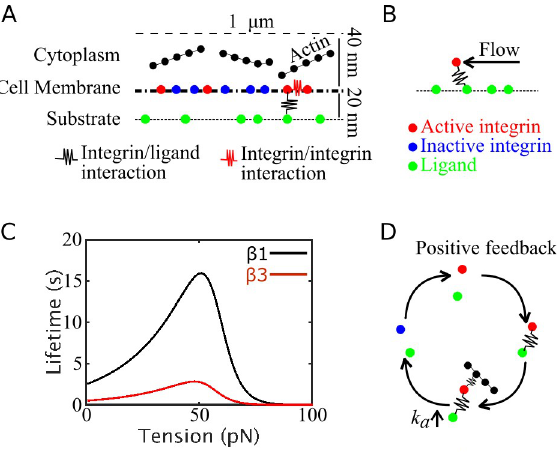
Fig 2. Schematic illustration of the model system. (A) Side view of the computational domain, where single-point, two-state integrin particles diffuse and assemble laterally. Upon activation (from blue to red), integrins can establish interactions (black spring) with ligands (green particles) and other active integrins (red springs). (B) Schematics of the system with actin flow: a force mimicking actin flow is exerted on ligand-bound integrins, parallel to the substrate, and builds tension on the integrin/ligand bond. (C) Lifetime versus tension curves of catch bonds used to mimic β -1 (black) and β -3 (red) integrins. (D) Schematic illustration of the positive feedback between actin filament binding and integrin activation. Once an integrin particle is bound to a ligand, it can establish interactions with actin. Upon binding actin, its activation rate increases. Upon deactivating and unbinding, its propensity to become active again increases, leading to increased probability of binding new ligands and actin filaments. This results in a positive feedback between ligand binding and engaging the actin cytoskeleton.